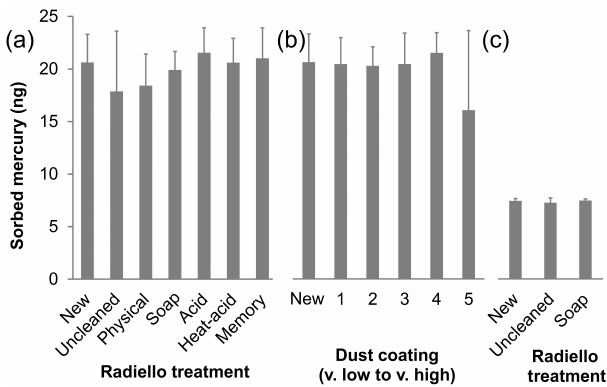
Figure 3. Mean sorbed mercury for differing Radiello ® cleaning treatments and at varying degrees of HGR-AC dust coating inside the Radiello ® (panel b ) from indoor experiment. Cleaning treat- ments and degree of dust coating is described in Sect. 2.2.3. Panel (a) also includes the memory effect treatment, which were un- cleaned Radiellos ® from deployments in a high concentration envi- ronment. Panel (c) presents the mean sorbed mercury for differing Radiello ® cleaning treatments from outdoor